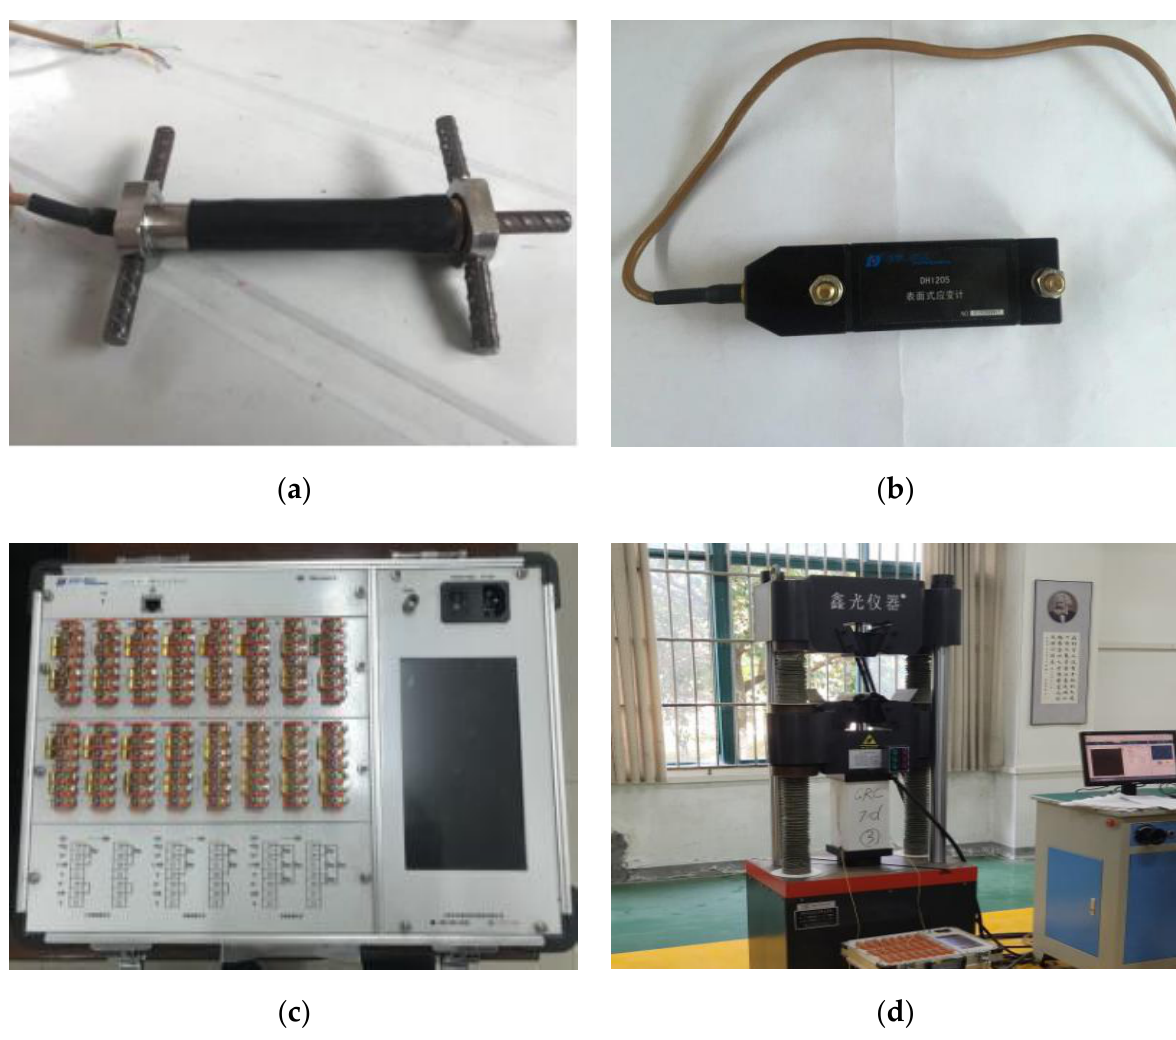
Figure 3. Equipment used in the experiment: ( a ) DH1204 embedded strain sensor; ( b ) DH1205 surface strain sensor; ( c ) DH3818Y static strain tester; ( d ) compression testing machine.